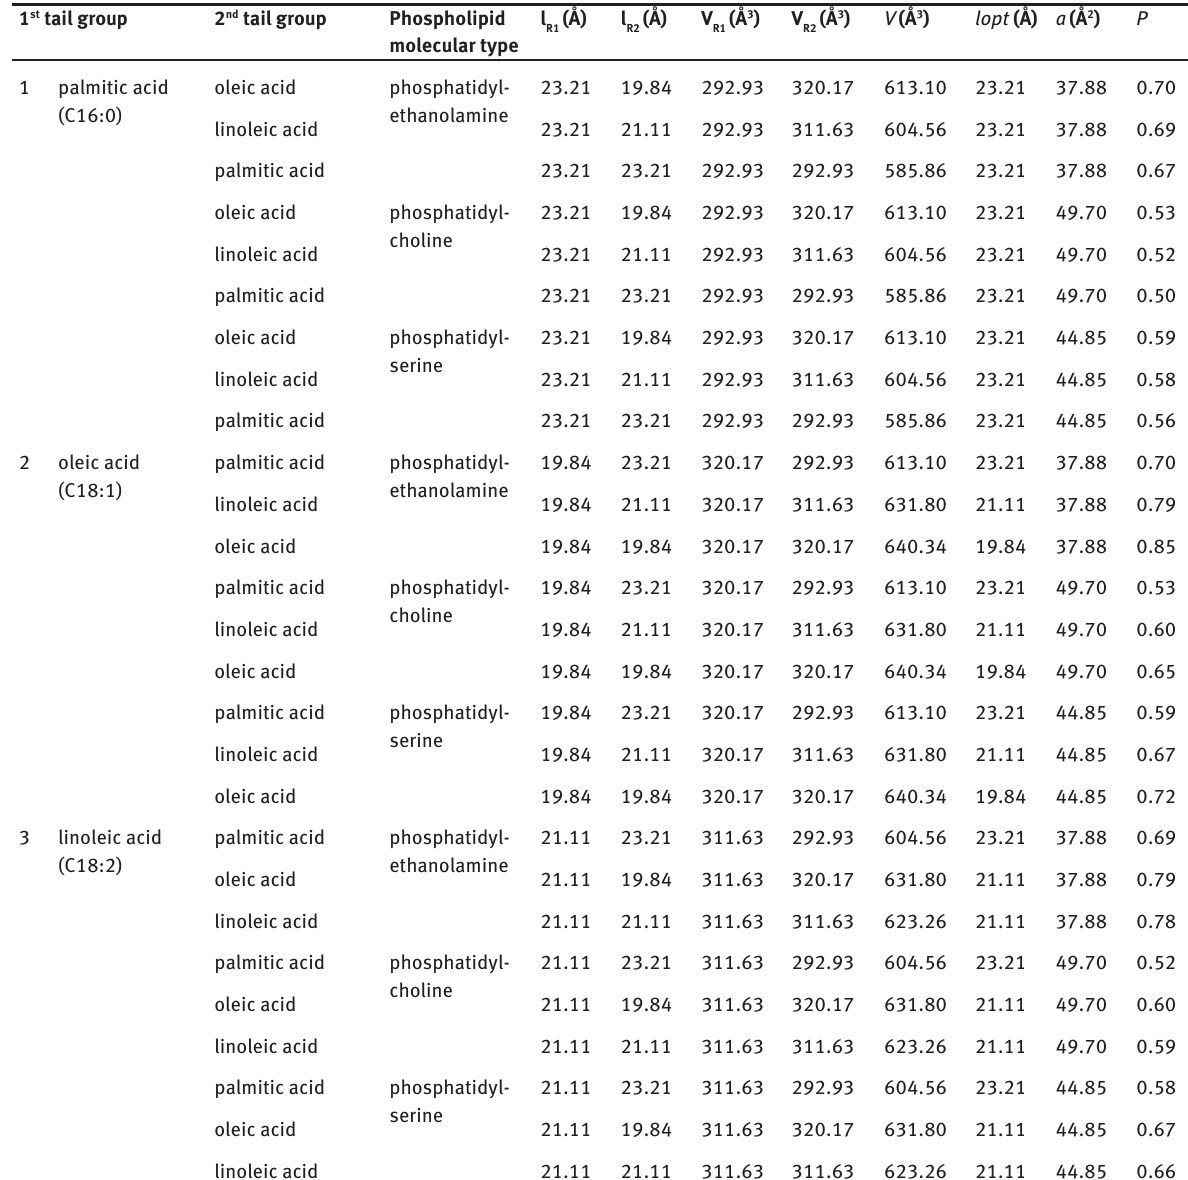
Table 1: Packing parameter ( P ) determination of sesame phospholipids. 1 st tail